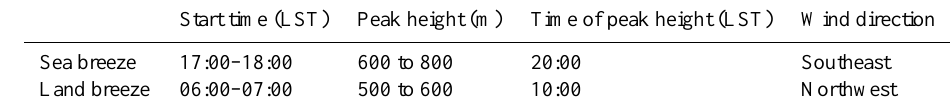
Table 2. Features of the sea-land breezes at the Xinken station during the observation periods.